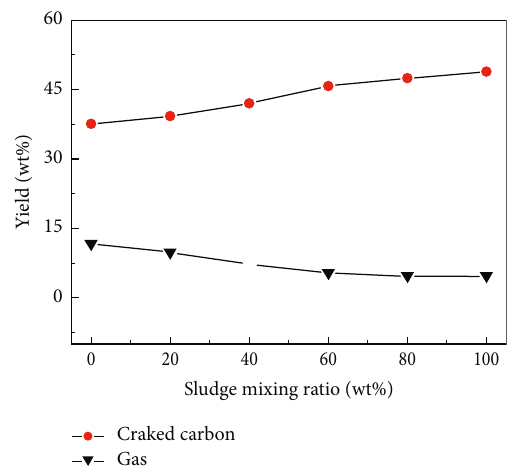
Figure 5: Copyrolysis oil yield curve of lexus algae and sludge as a function of mixing ratio.